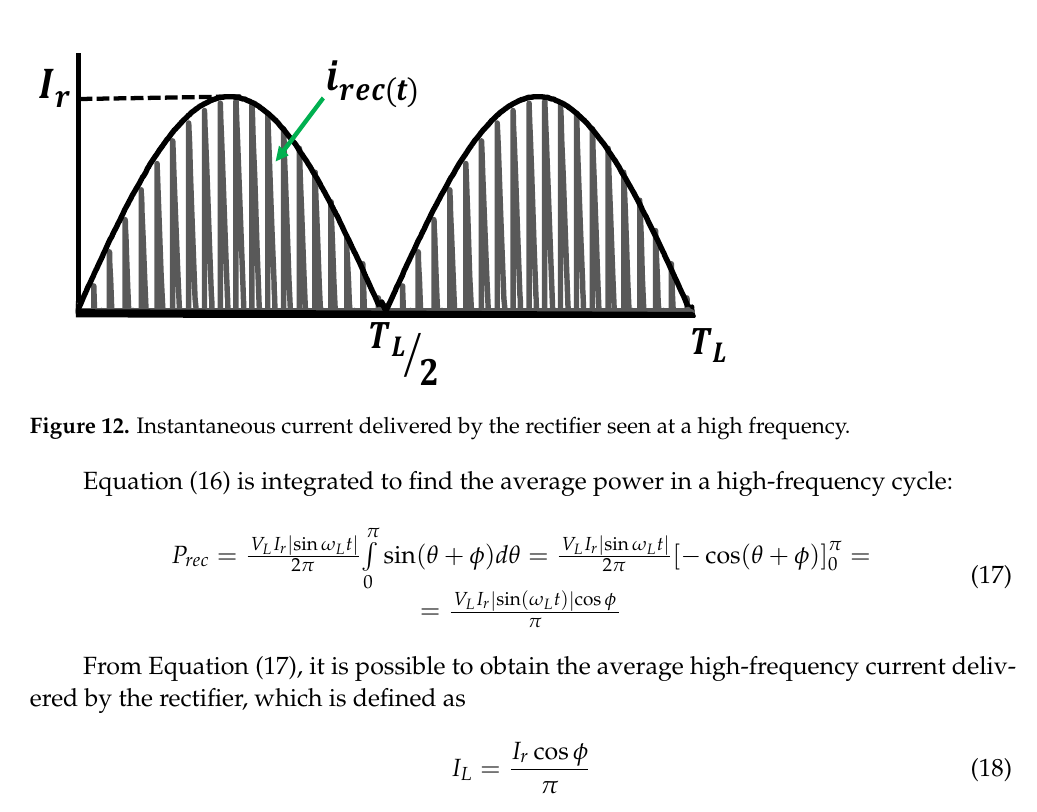
Figure 13. Instantaneous current delivered by the rectifier seen at a high frequency. With Equations (19) and (9), it is possible to calculate the instantaneous power deliv- ered by the rectifier at a low frequency, which is defined as '